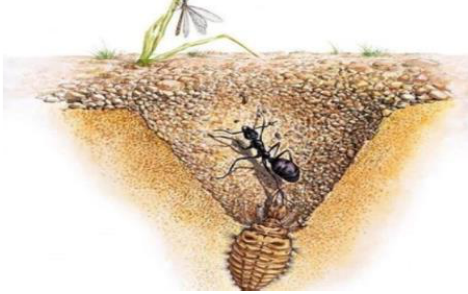
Figure 4. Predation behavior of the antlion.